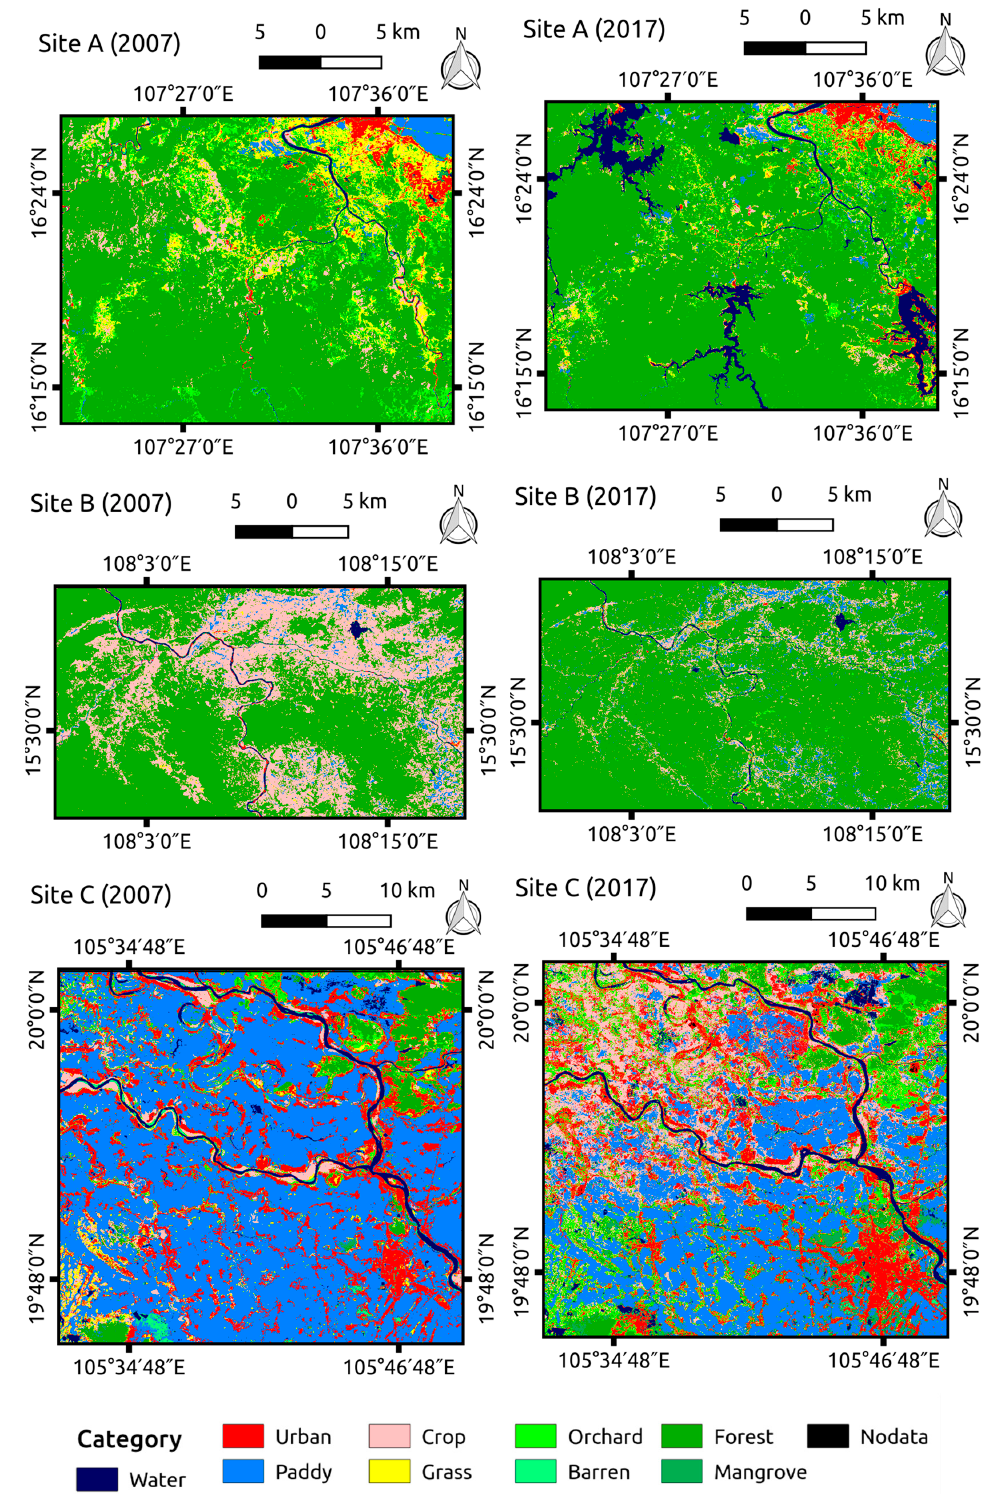
Figure 6. The selected sites for land cover change detection for the period 2007 to 2017 over Central Vietnam; Site A, B, and C are in Thua Thien Hue, Quang Nam, and Thanh Hoa provinces,